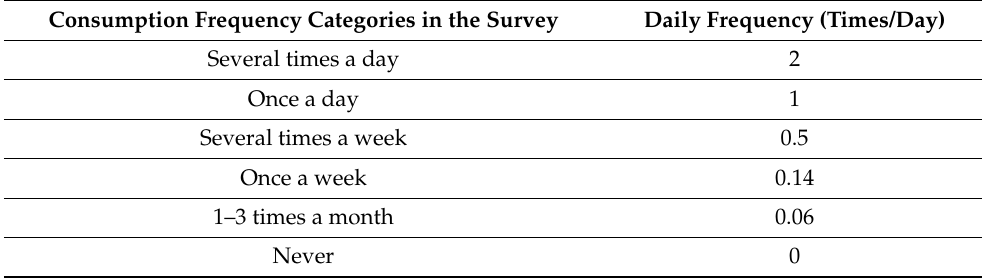
Table 1. Indicators for conversion of frequency of consumption of organic products. Consumption Frequency Categories in the Survey Daily Frequency (Times/Day) Several times a day 2 Once a day 1 Several times a week 0.5 Once a week 0.14 1–3 times a month 0.06 Never